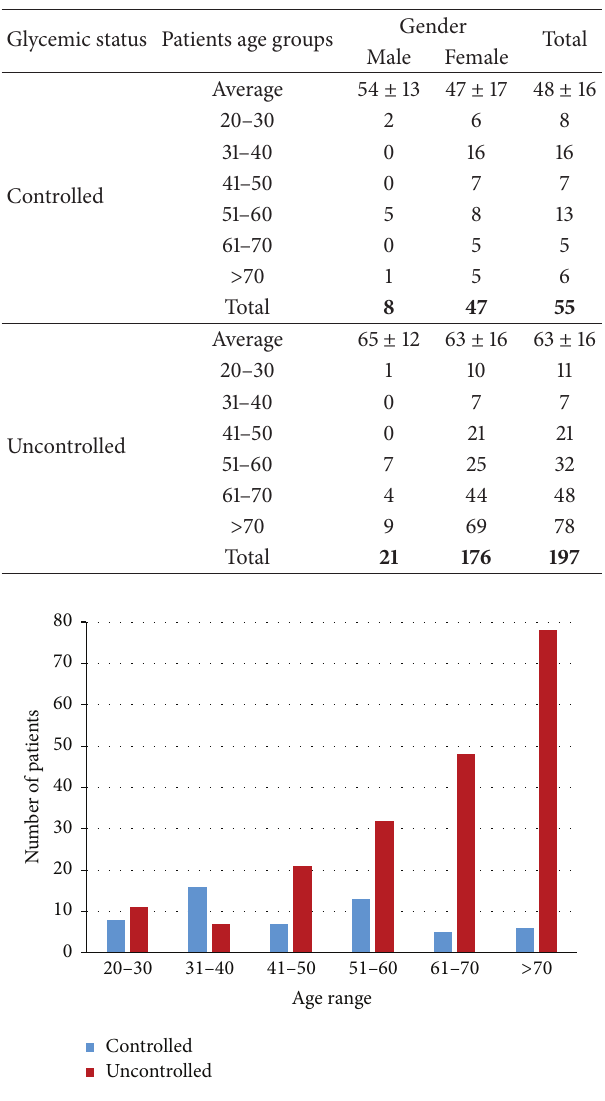
Figure 1: Distribution of UTI cases according to age ranges and glycemic status of our diabetic